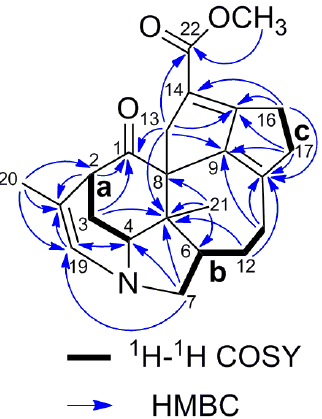
Figure 4. Selected 2D NMR correlations of calyciphylline Q ( 3 ).